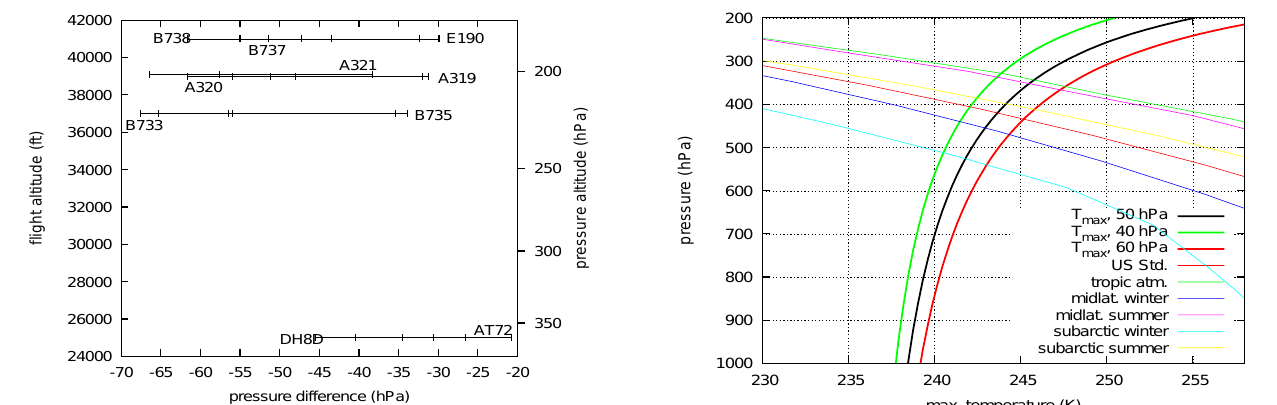
E190 B735 Fig. 1. Pressure differences ∆ p above minus below the wings of various aircraft representing more than half of European air traf- fic in 2011. ∆ p has been calculated by dividing weight by wing area. Error bars around a central reference value indicate pressure differences at maximum and minimum weights. Maximum flight altitudes in feet and corresponding pressure altitudes are given on the vertical axes. The aircraft types are: A320 (AIRBUS A-320), B738 (BOEING 737-800), A319 (AIRBUS A-319), A321 (AIR- BUS A-321), DH8D (DHC-8-400 DASH), B733 (BOEING 737-